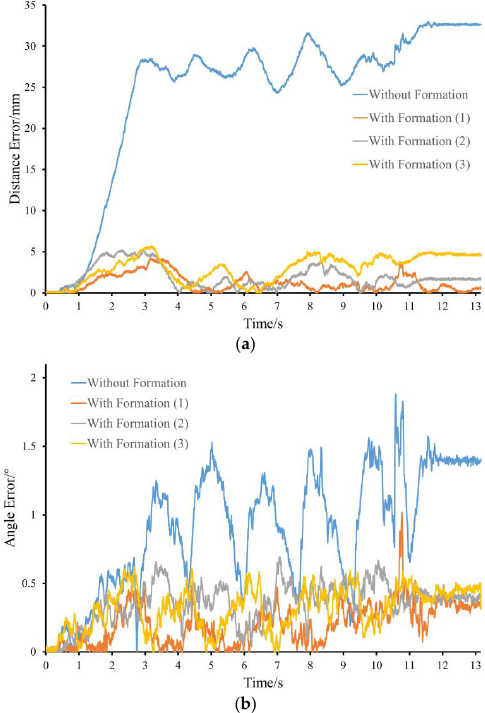
Figure 13. Formation motion Error: ( a ) distance/mm; ( b ) angle/°.